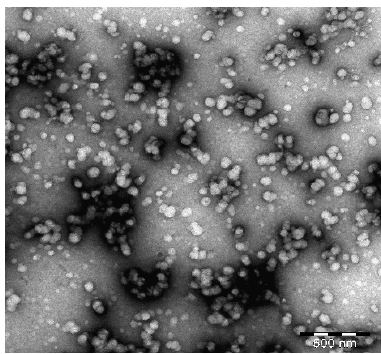
Figure 3. Transmission electron microscope photograph of optimized luliconazole spanlastics.